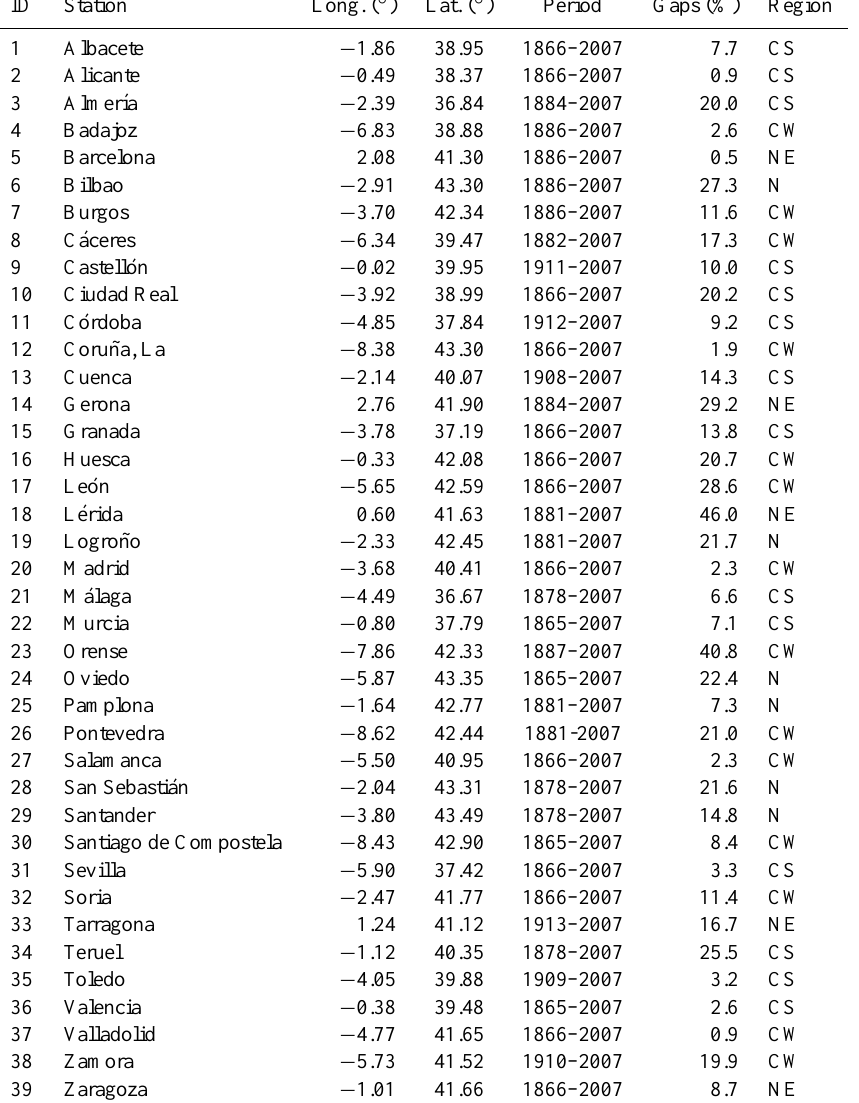
Table 2. Details of the 39 Spanish stations with TCC series considered in this